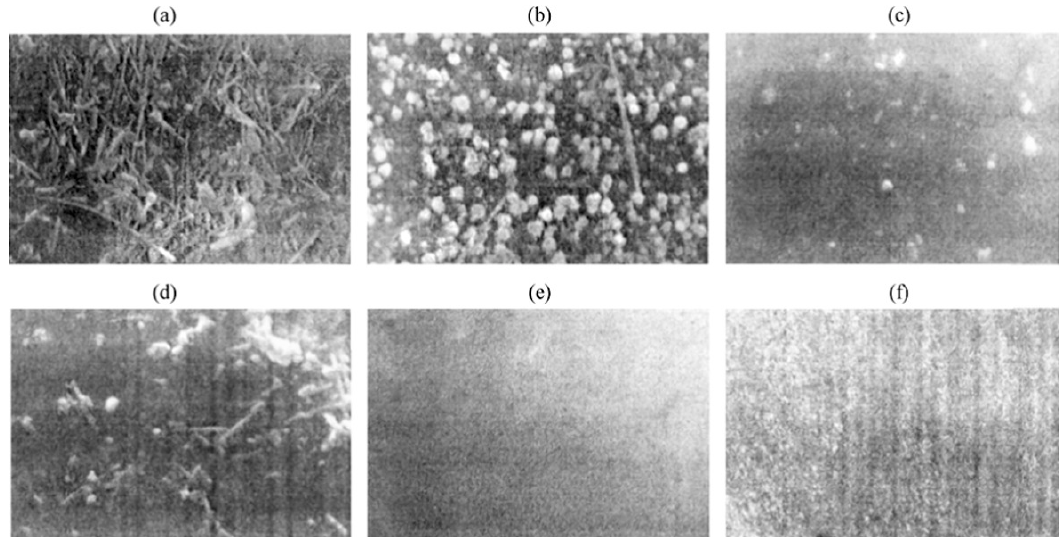
Figure 23. SEM micrographs of ( a , b , e ) upper and ( c , d , f ) lower surfaces of ( a – d ) PAI-NTII(10) and ( e , f ) PAI-NTII(20) of thickness 20 μ m [112].